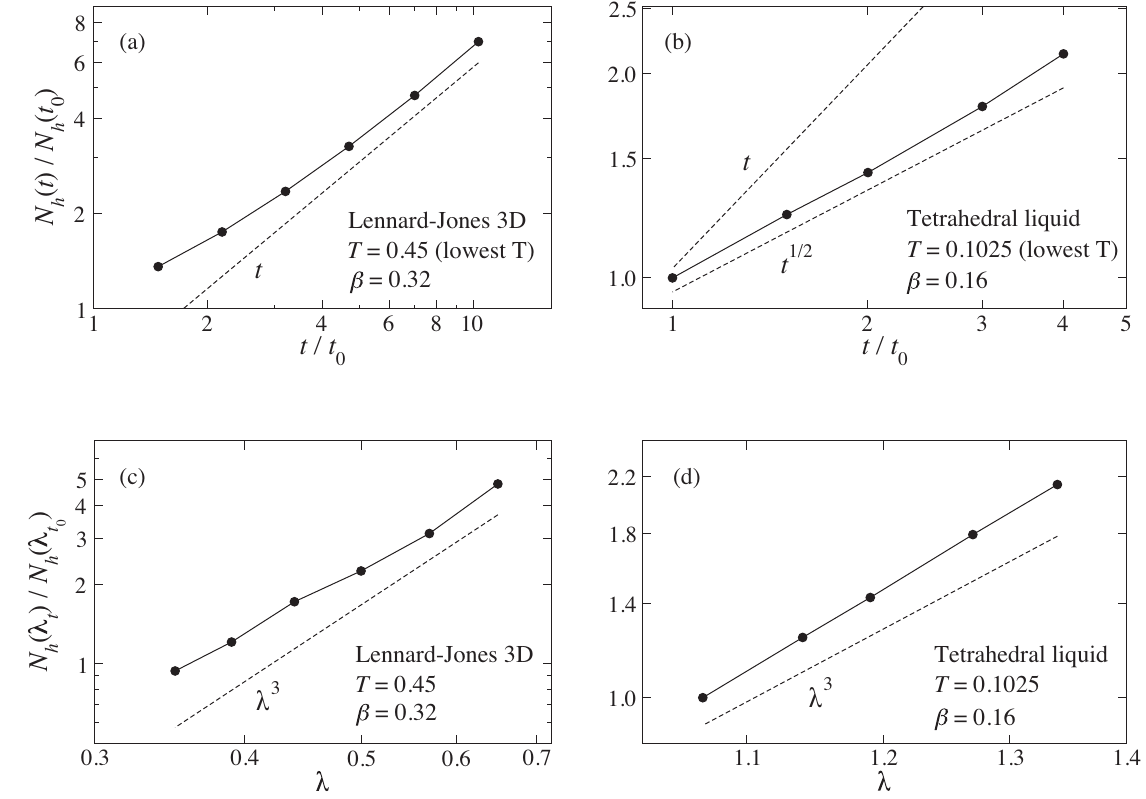
FIG. 10. N h ð t Þ normalized by N h ð t 0 Þ for the 3D Kob-Andersen binary mixture at T ¼ 0 . 45 (a) and the tetrahedral gelling system at T ¼ 0 . 1025 (b) both obtained by integrating the exponential tails shown in Fig. 9. N Andersen binary mixture at T ¼ 0 . 45 (c) and the tetrahedral gelling system at T ¼ 0 . 1025 (d). Dashed lines in all the figures are different power laws shown as